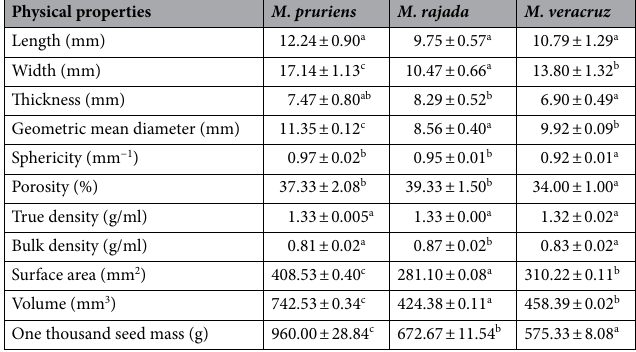
Table 1. Physical properties of different varieties of Mucuna beans. Means with the different alphabets are significantly different at P < 0.05 along the same row.